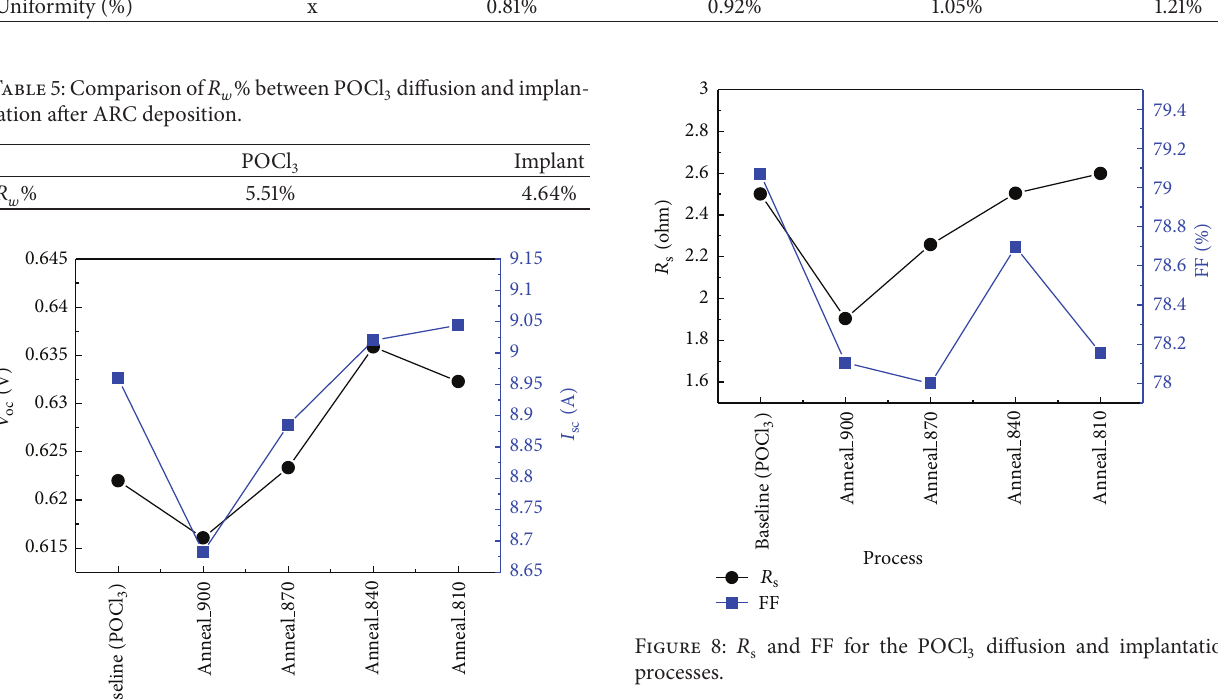
and FF for the POCl 3 diffusion and implantation s